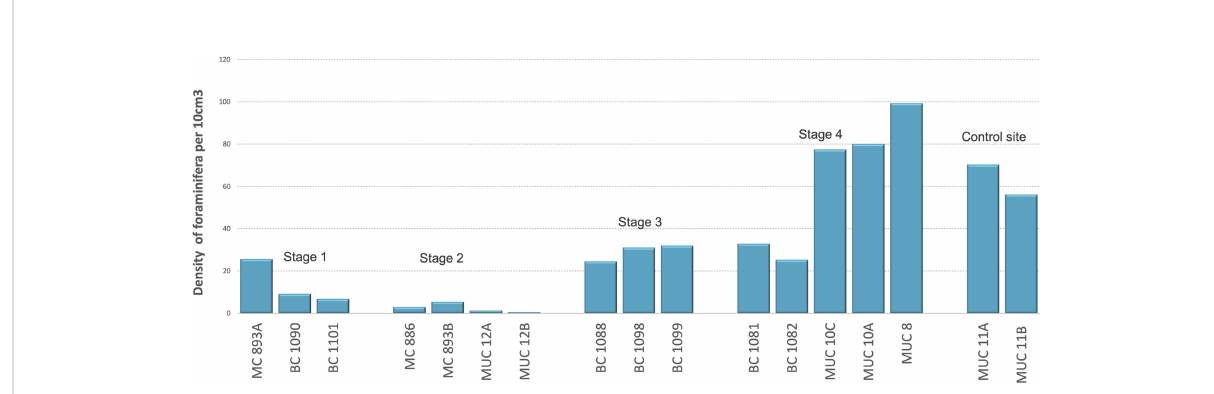
FIGURE 3 Number of Rose Bengal-stained foraminifera (calcareous and agglutinated) for each Stage (S) of environmental succession, per 10 cm 3 of the sediment. Student ’ s t-tests: S1: S2 p = 0.01; S1: S3 p = 0.00; S1: 4 p = 0.03; S1: control site p = 0.00; S2: S3 p = 0.00; S2: S4 p = 0.00; S2: